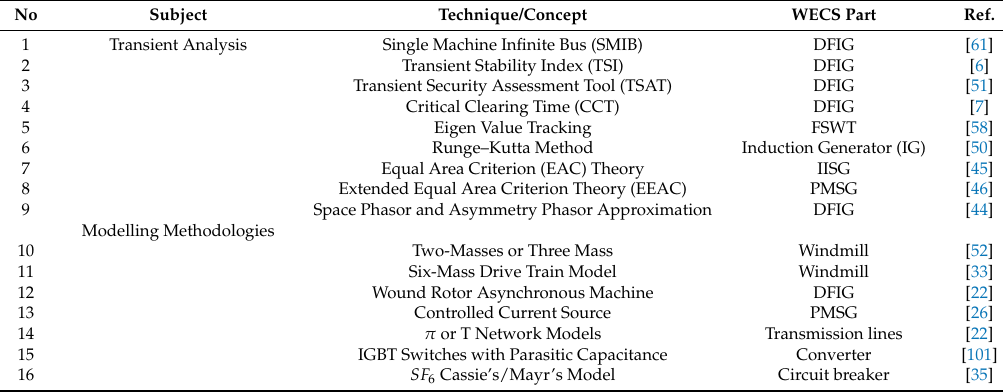
Table 3. Transient stability evaluations techniques in various WECS applications. IISG, inverter interface synchronous